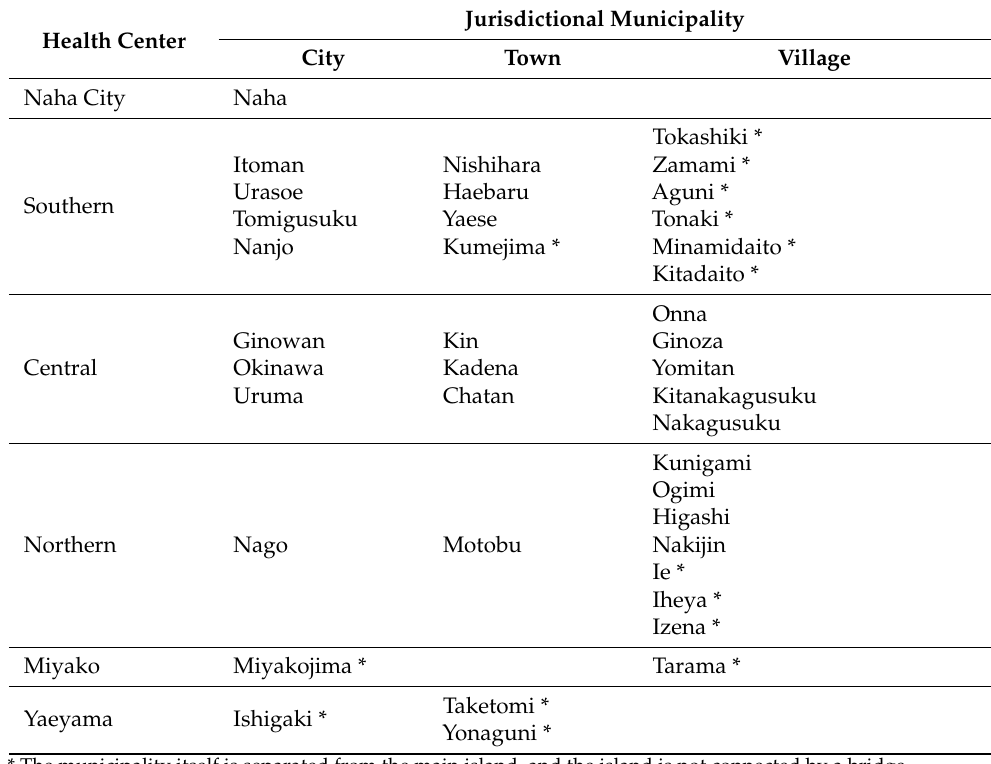
Table A1. Municipalities under the jurisdiction of health centers.